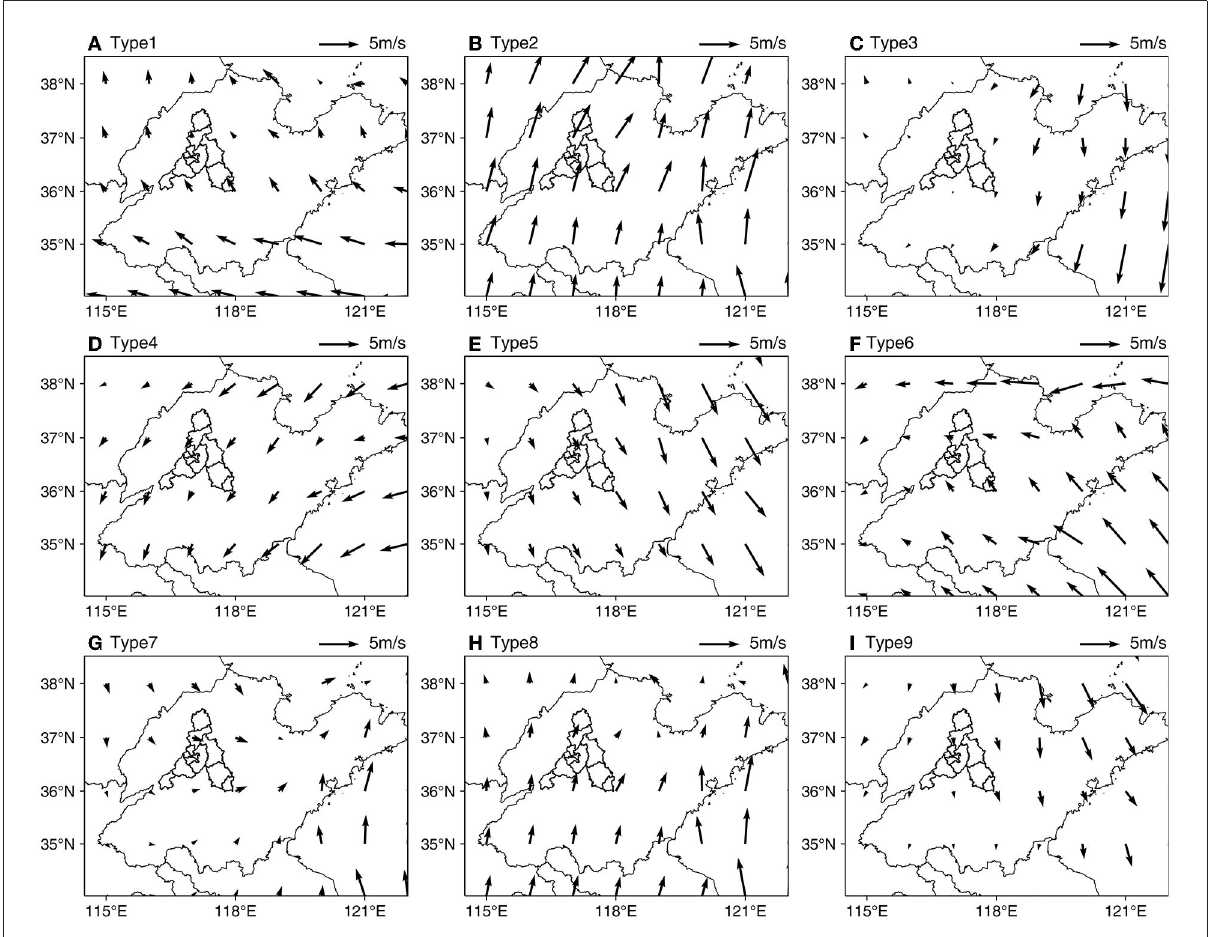
FIGURE8 The 10-m wind in 9 synoptic patterns during 2013–2020 in North